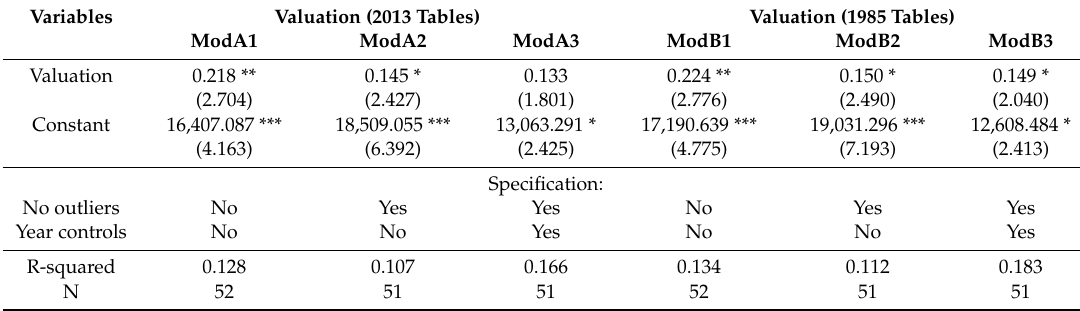
Table 3. Valuation accuracy test 1 (dependent variable is sale price in PLN / ha).